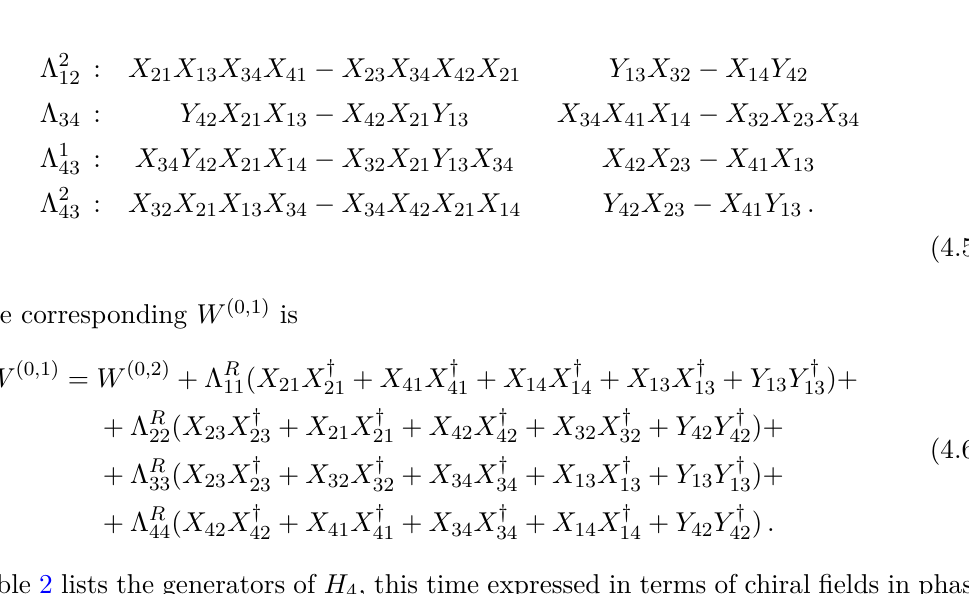
Figure 10 . Quiver diagram for phase B of H 4